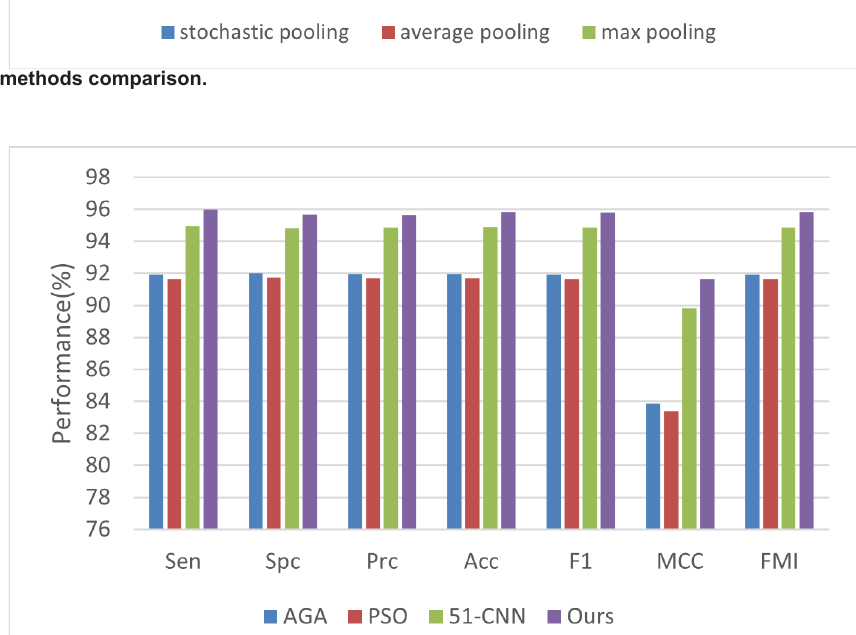
Figure 10. Comparison plot.